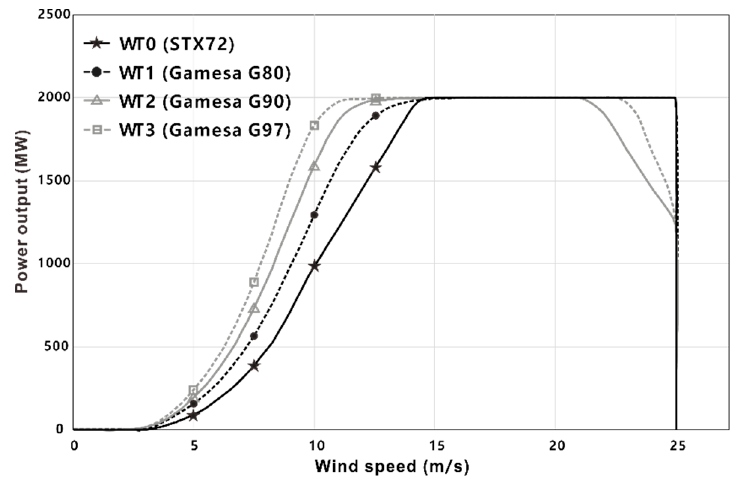
Figure 4. Power curves of 2 MW wind turbines.